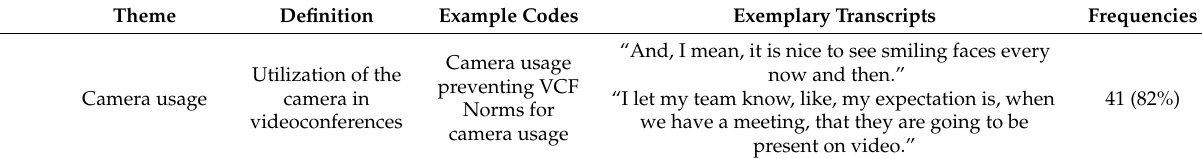
Table 2. Themes and Codes Identified from Study 2: Stressors Concerning Videoconferences and Coping